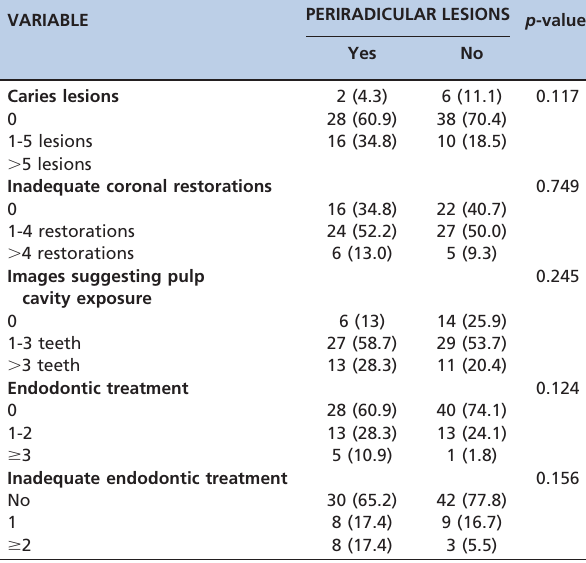
Table 4- Bivariate analysisbetweenperiradicularlesionsand the radiographic characteristics of the study population.